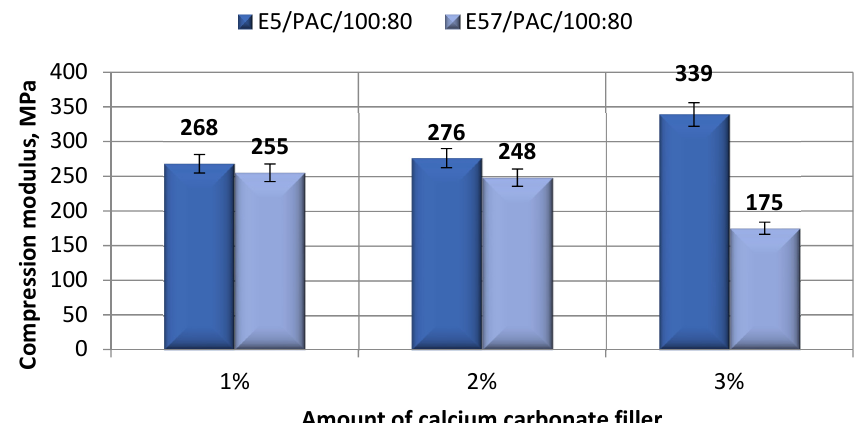
Figure 11. Comparison of the compression modulus between the E5 / PAC / 100:80 and E57 / PAC / 100:80 epoxy specimens modified by the calcium carbonate filler post-climate chamber